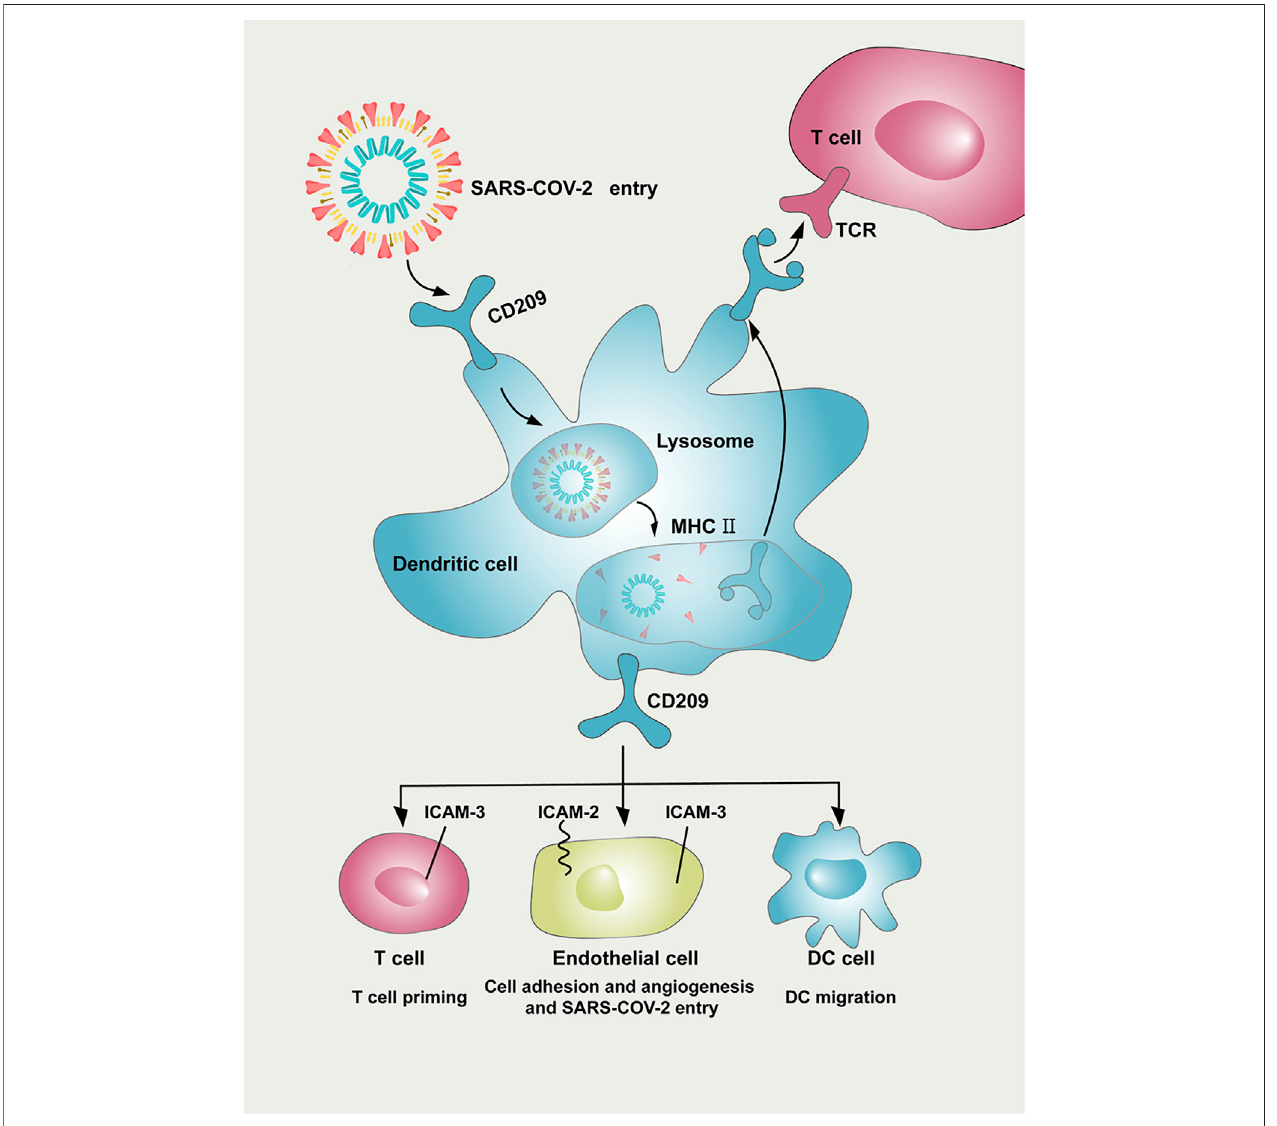
FIGURE 7 | Potential implication of CD209 inhibitor in preventing SARS-CoV-2 damage in tumor patients. CD209 expressed in dendritic cells helps deliver SARS- CoV-2 antigen to the T-cell surface. CD209 mediates a variety of intercellular interactions among endothelial cells, DCs, and T cells. CD209 cell ligands (ICAM-2 and ICAM-3) are expressed in DCs, T cells, and endothelial cells, leading to multiple immunomodulation and other interactions between T cells, DCs, and endothelial cells. The CD209/ICAM-2/ICAM-3 interaction in endothelial cells can regulate endothelial adhesion and angiogenesis properties. As apotential receptor for SARS-CoV- 2,CD209inhibitorsmightalsopossessbene fi cialtherapeuticeffectsonSARS-CoV-2treatmentandworktogetherwithothereffectivestrategies.Abbreviation:ICAM-2, intercellular cell adhesion molecule-2; ICAM-3, intercellular cell adhesion molecule-3, DC: dendritic cell; MHC: major histocompatibility complex; TCR: T cell receptor.